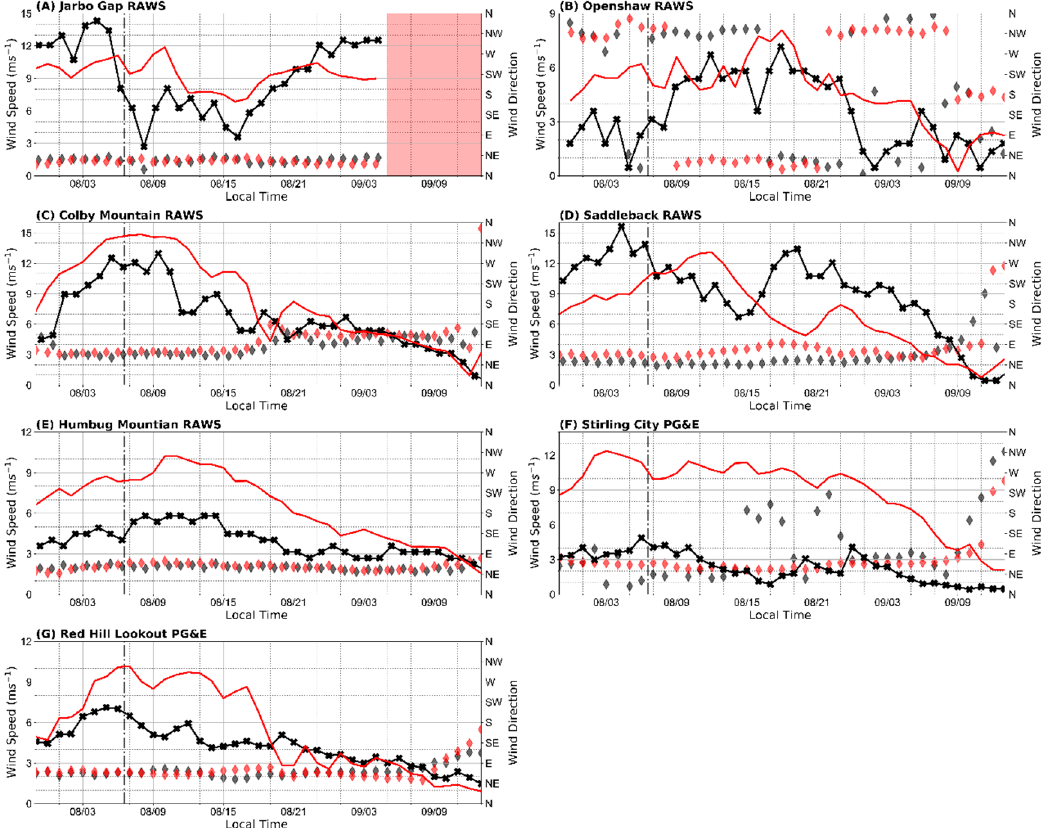
Figure 11. Time series of WRF 10 m wind speed (red lines) and direction (red diamonds) and the observed wind speed (black line with Xs) and direction (black diamonds) for each weather station ( A–G ) as in Figure 7. Dashed vertical line indicates approximate ignition time of the fire, and the red box in subplot ( A ) indicates where the station data are questionable and therefore omitted.